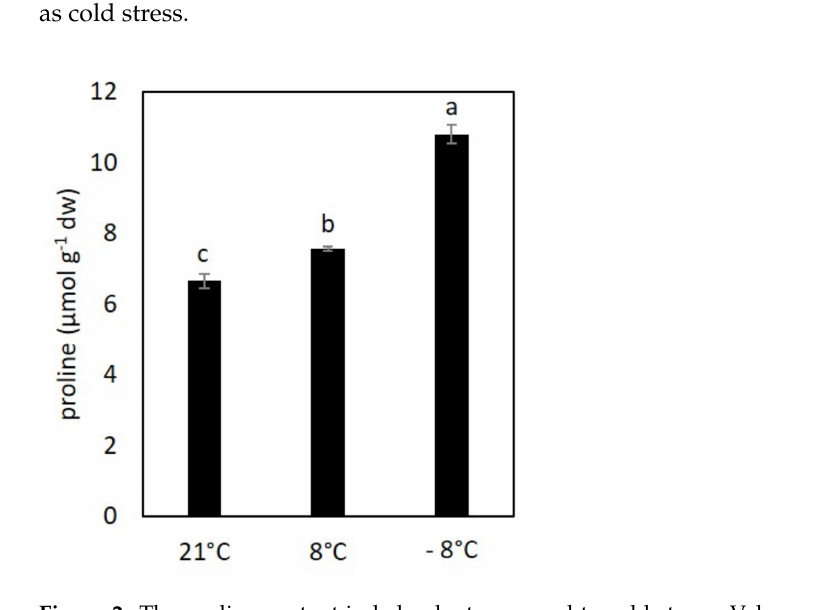
Figure 2. The proline content in kale plants exposed to cold stress. Value marked with different letters are significantly different at p <